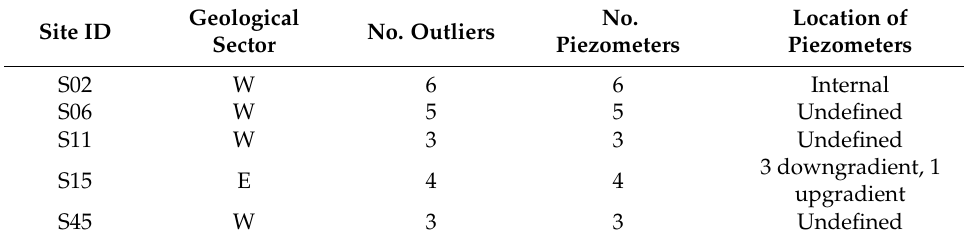
Table 2. Summary of the temporal As